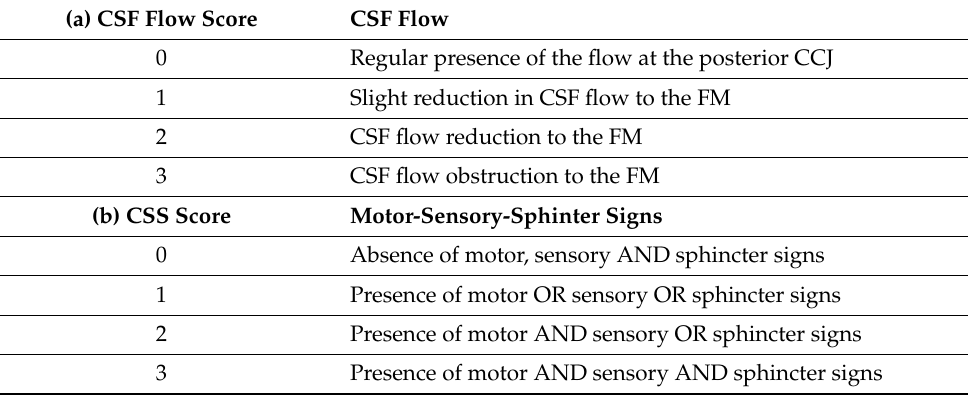
Table 1. CSF flow score and the clinical sign score